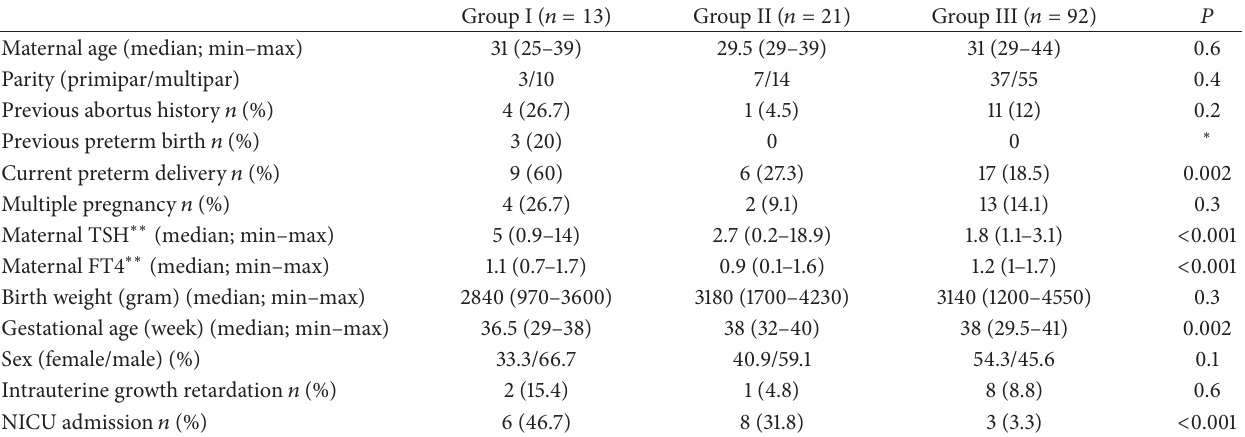
Table 1: Demographic and laboratory characteristics of